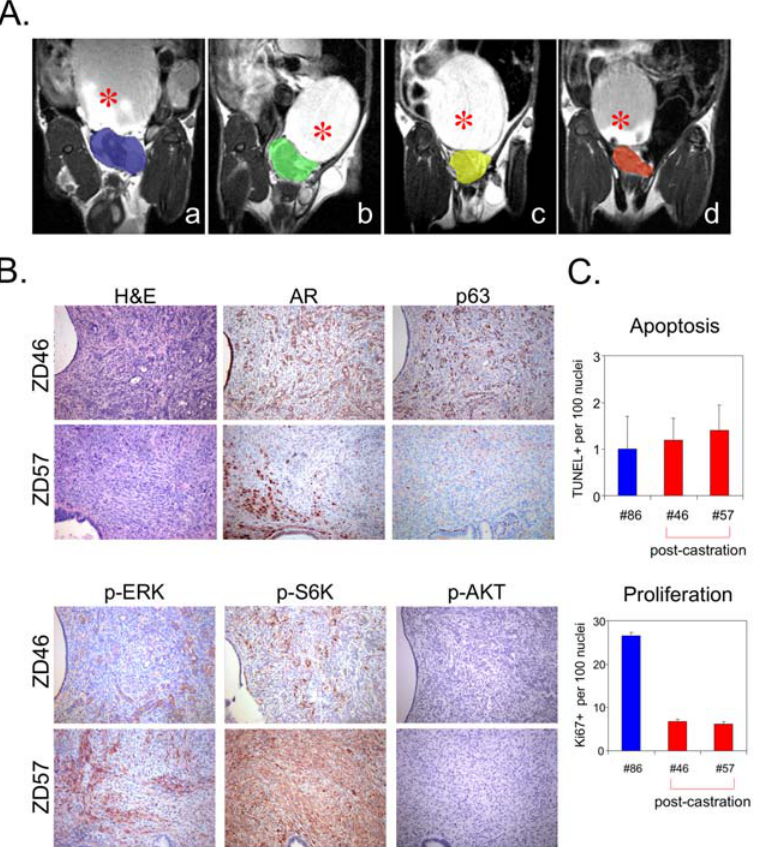
Figure 6. iBRAF* PCA progress to indolent androgen-independence after castration. A. The reduction of tumor volumes was monitored by MRI over a 4-week time course after castration ( a , tumor (blue) 1 week after castration; b , tumor (green) 2 weeks after castration; c , tumor (yellow) 3 weeks after castration; d , tumor (orange) 4 weeks after castration). Asterisk indicates bladder. B. Histological examination confirmed the presence of prostatic tumor cells in two castrated iBRAF* mice ( # 46 and # 57). The two post-castration tumors were positive for AR (a prostatic luminal cell marker) and p63 (a basal cell marker) by IHC. Also, the post-castration tumor cells were negative for p-AKT, but remained strongly positive for p-ERK and p-S6K on IHC. C. The post-castration tumor cells were viable and growing, not residual tumor remnants, as manifested by low apoptosis index (1.2 ( + / 2 0.45) and 1.4 ( + / 2 0.55) per 100 nuclei for # 46 and # 57, respectively) on TUNEL, comparable to pre-castration tumor (1.0 ( + / 2 0.71)) (top), and active proliferation by Ki67 staining, albeit at rate much lower than that of pre-castration tumor (6.8 ( + / 2 3.6) and 6.2 ( + / 2 2.2) for # 46 and # 57, respectively and 26.6 ( + / 2 3.6) in the pre-castrated tumors) (bottom).